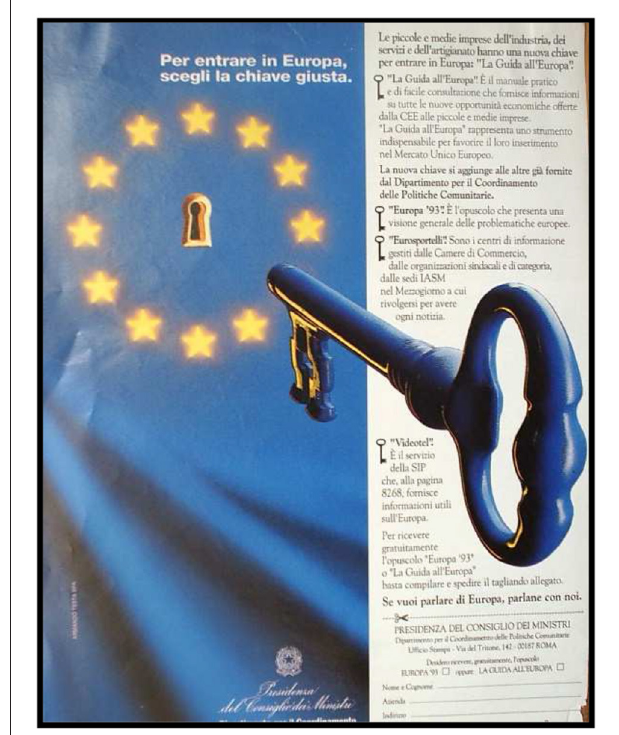
FIGURE 5 | To enter Europe, choose the right